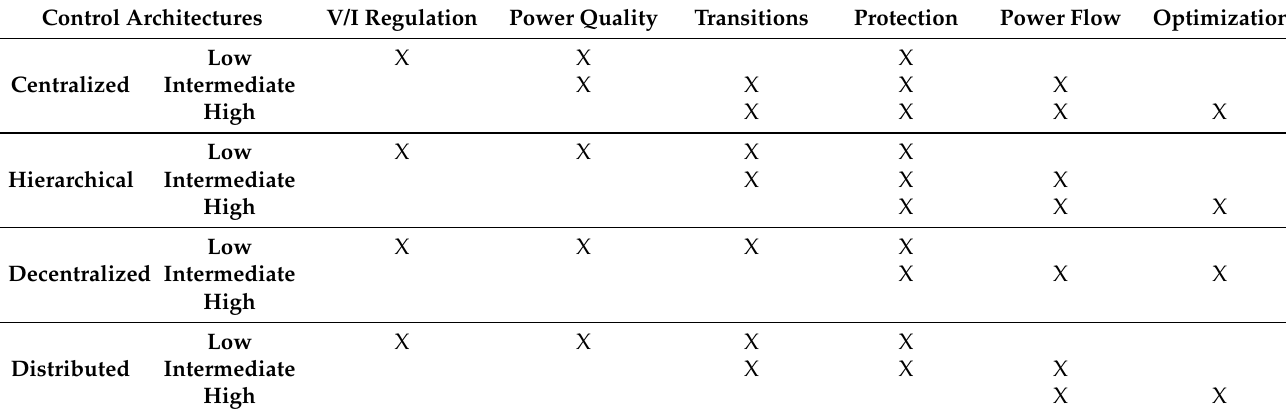
Table 5. The information architectures and their relationship with control